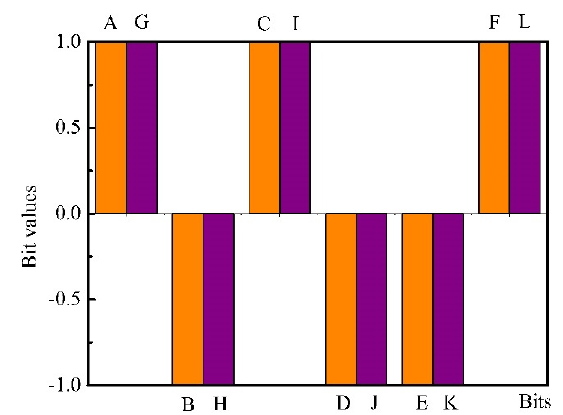
Figure 8. Reproducibility of the ternary fingerprints. Orange: measurement-1; maroon: measurement- 2 (of the same sample).